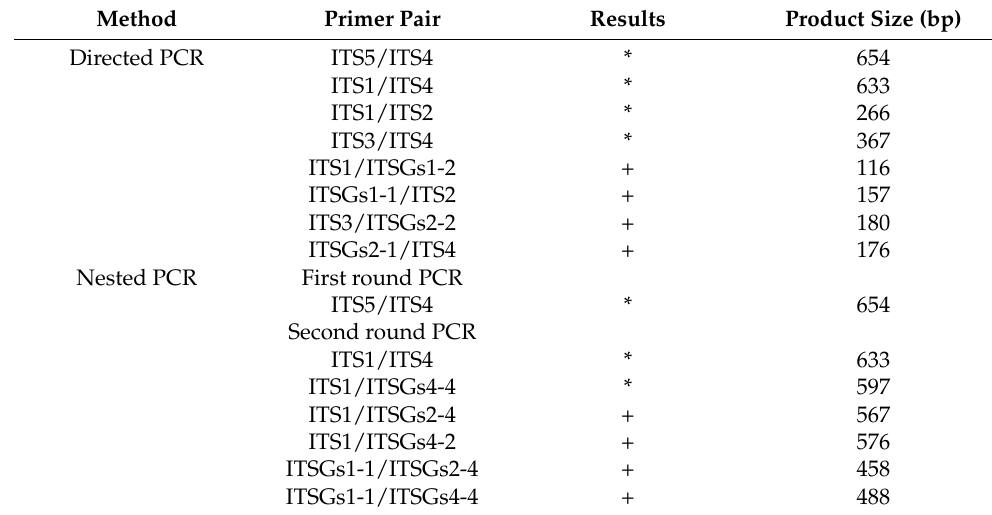
Table 4. The results of PCR